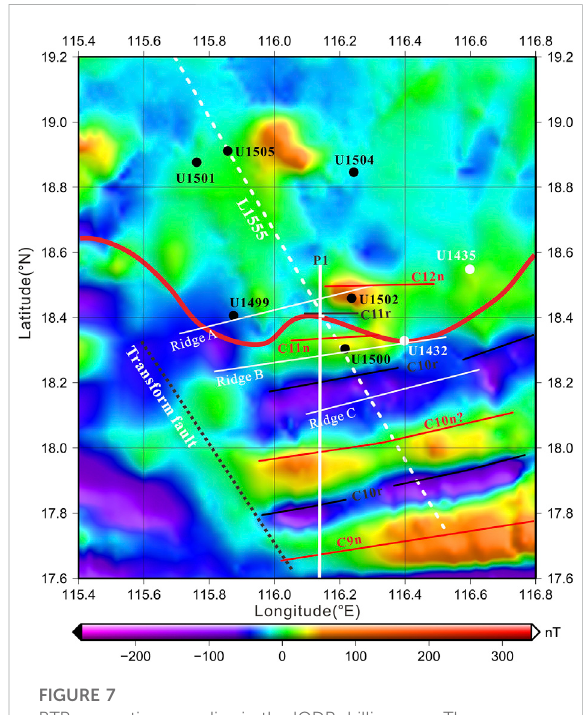
FIGURE 7 RTP magnetic anomalies in the IODP drilling area. The magnetic lineations in the black and red solid lines are the same as thoseinFigures1,2,5.TheredthicklineshowstheCOB.Theblack dottedlineshowsthetransitionfaultandthethreewhitesolid lines show Ridge A, Ridge B, and Ridge C (Larsen et al., 2018).